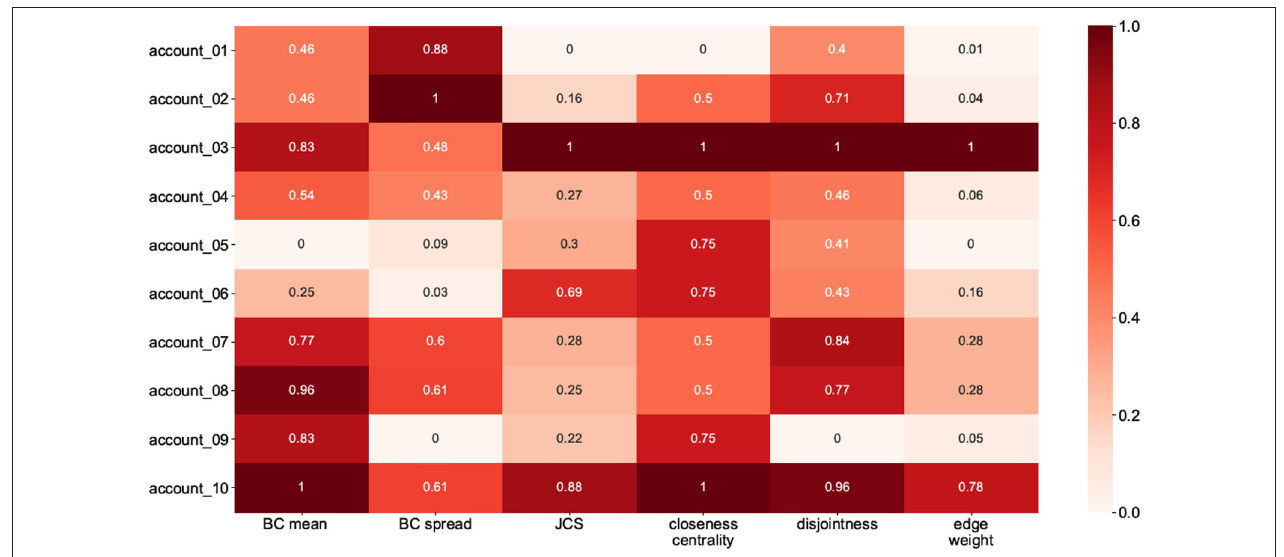
FIGURE 10 | Ten candidate accounts and their corresponding values for